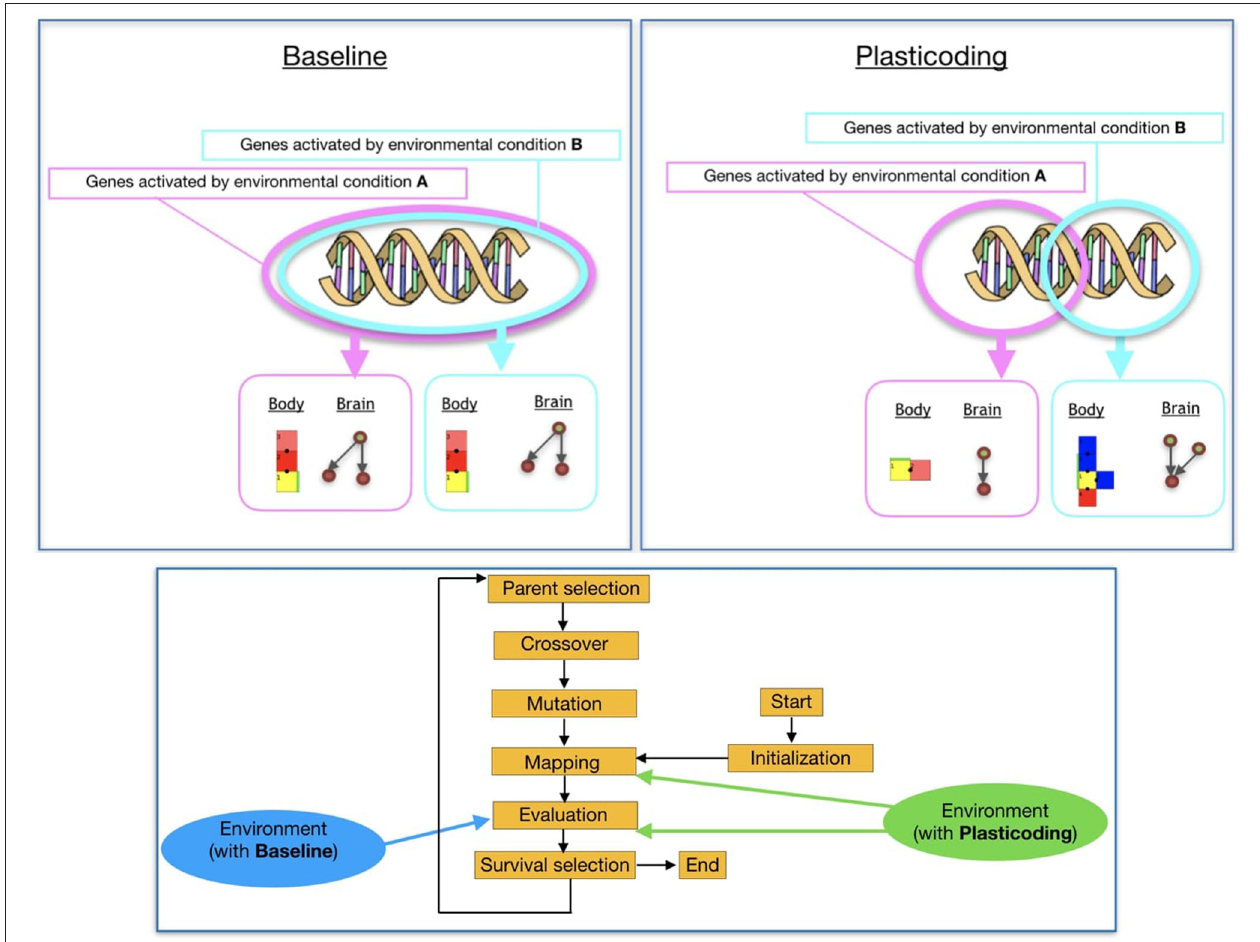
FIGURE 1 | On the left, the robot modules: Core-component, which carries a controller electronic board and inertial measurement unit (IMU) sensors (C); Structural brick (B); Active hinges with servo motor joints in the vertical (A1) and horizontal (A2) axes; and Touch sensor (T). The polygons above the module’s pictures are used to illustrate robot parts in the results section, and the letters are used to represent the modules in the robot representation. Modules C and B have attachment slots on their four lateral faces, and A1 and A2 have slots on their two opposite lateral faces; T has a single slot which can be attached to any slot of C or B. In the middle, an example of a robot (top-down view) before the simulation starts, while on the right, the same robot is shown during